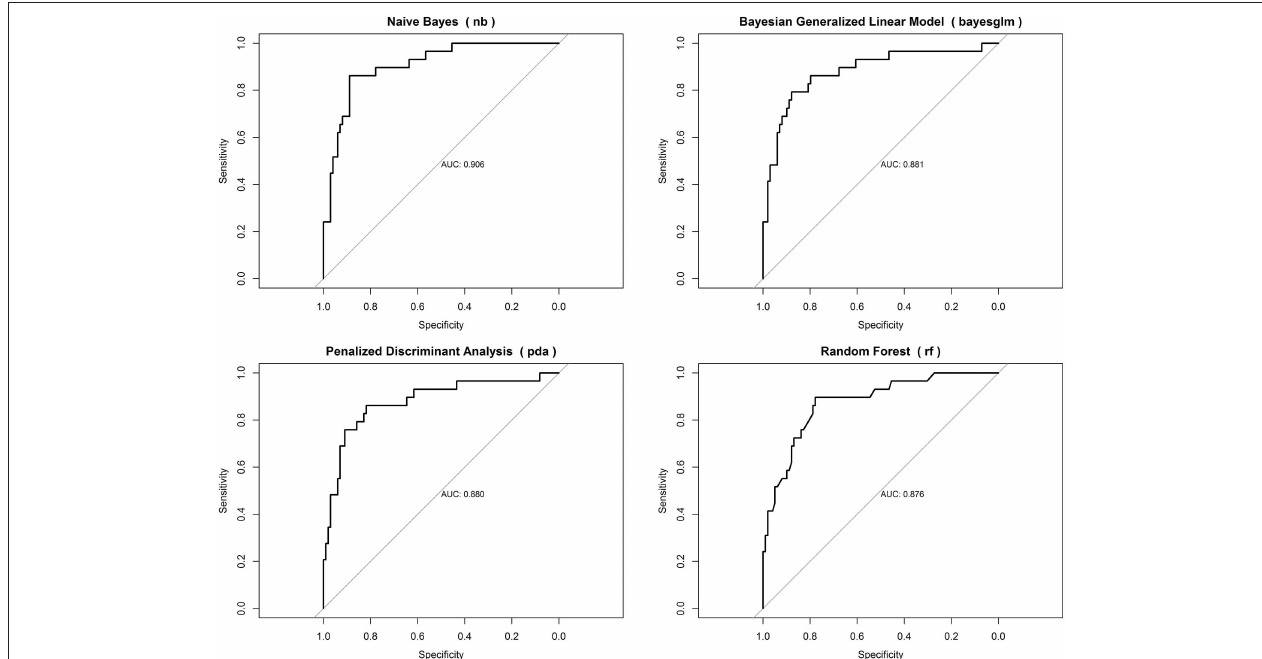
FIGURE 1 | Area under the curve for top-performing models predicting 14 day mortality.